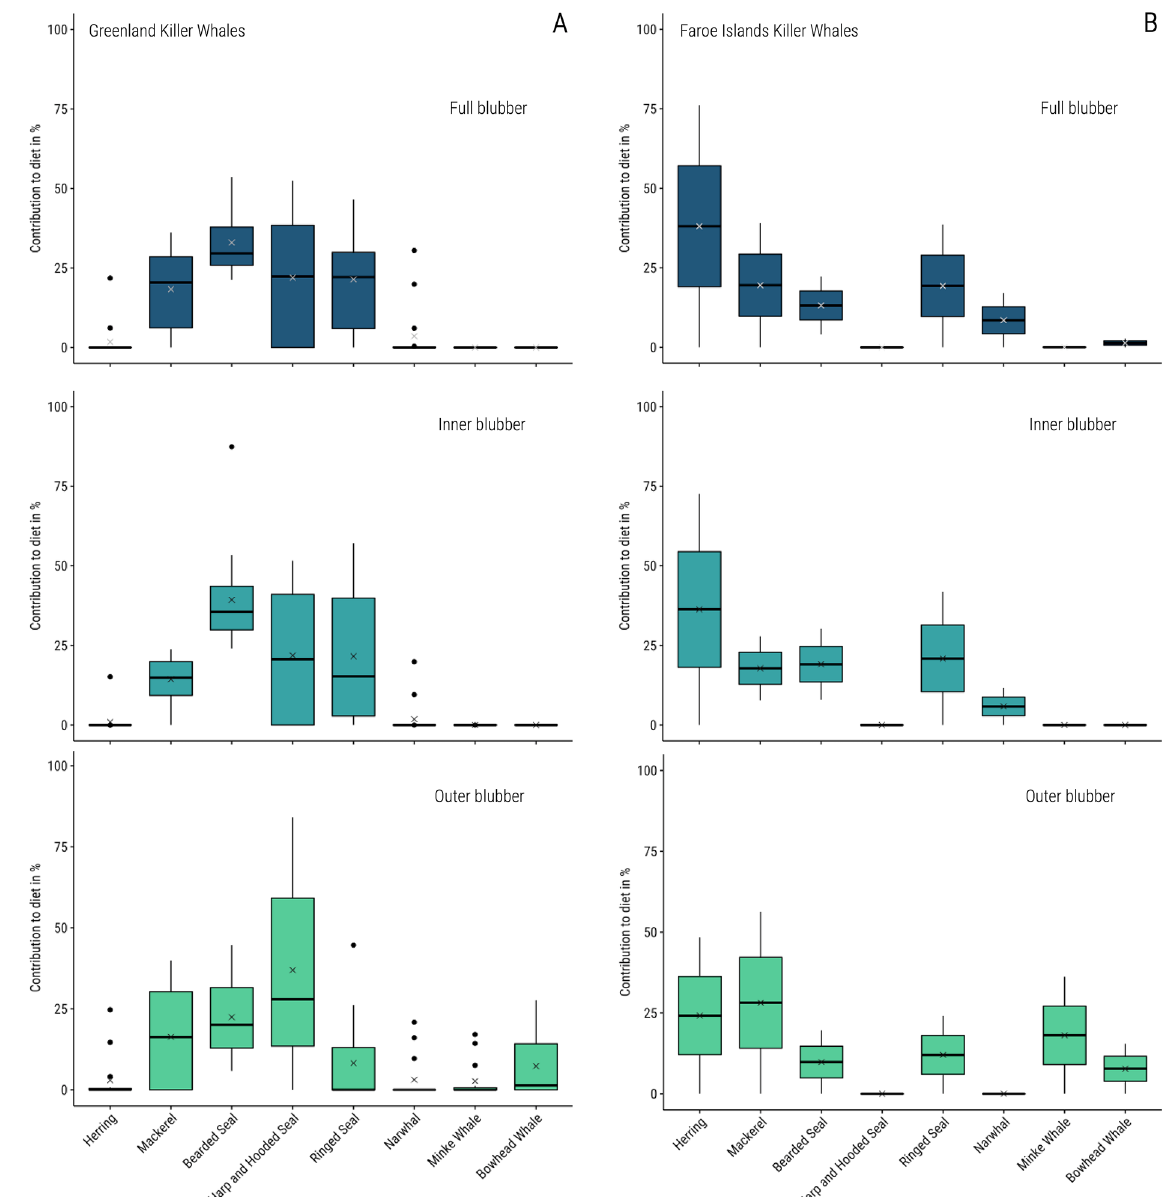
Figure 4. Proportions of different prey species estimated in the diets of ( A ) Greenland (n = 16) and ( B ) Faroe Islands (n = 2) killer whales based on the validated quantitative fatty acid signature analysis (QFASA) approach for killer whales. For outer layer, inner layer, and full depth FA signatures, outer layer, inner layer, and full depth calibration coefficients (CCs) were used, respectively. The estimates were lipid-corrected to account for differences in lipid between the prey items. The crosses show the mean, the thick bar shows the median, and the box extremities show the lower and upper